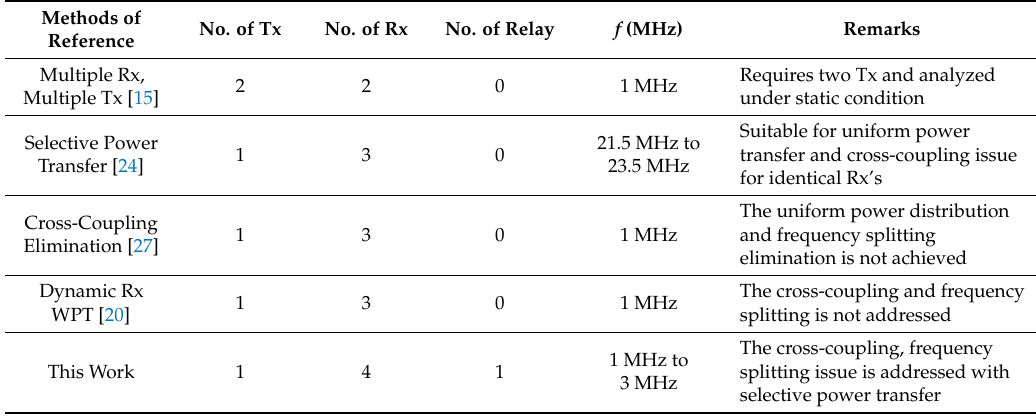
Table 5. Comparison of Proposed Method with Literature for Multiple Receiver WPT.